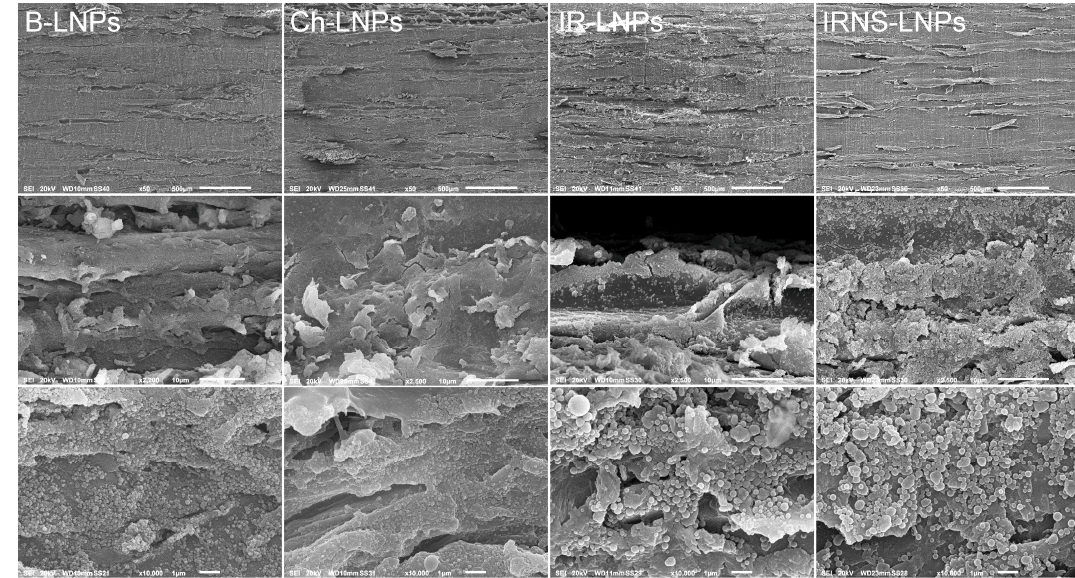
Figure 7. SEM micrographs at different magnifications (150×, 2200 – 2500×, 10000×) of the beech wood surfaces coated with LNPs from beech, chestnut, Iroko, and mixed Iroko–Norway spruce (B-LNPs, Ch-LNPs, IR-LNPs, IRNS-LNPs).